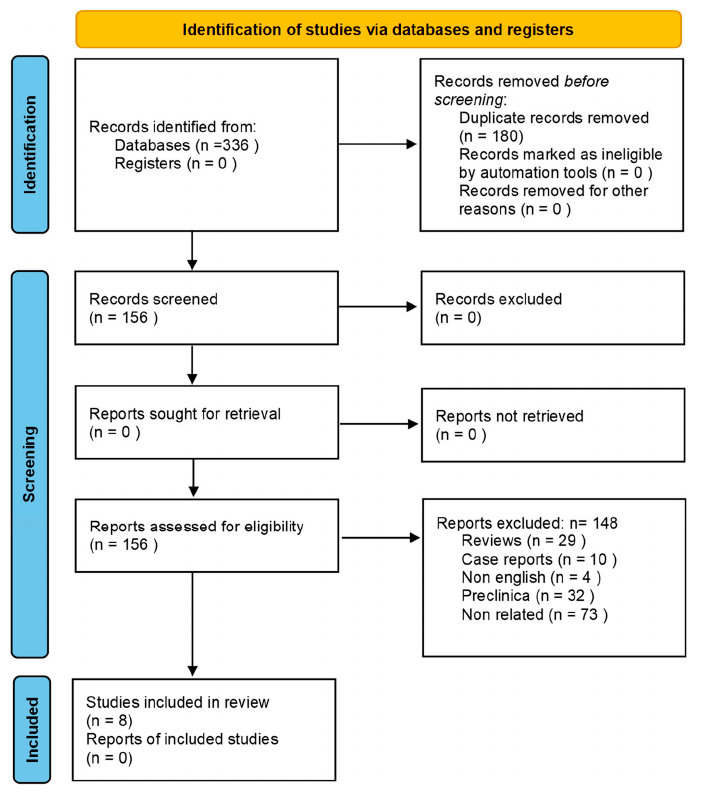
Figure 1. PRISMA Figure 1. PRISMA flow-chart.